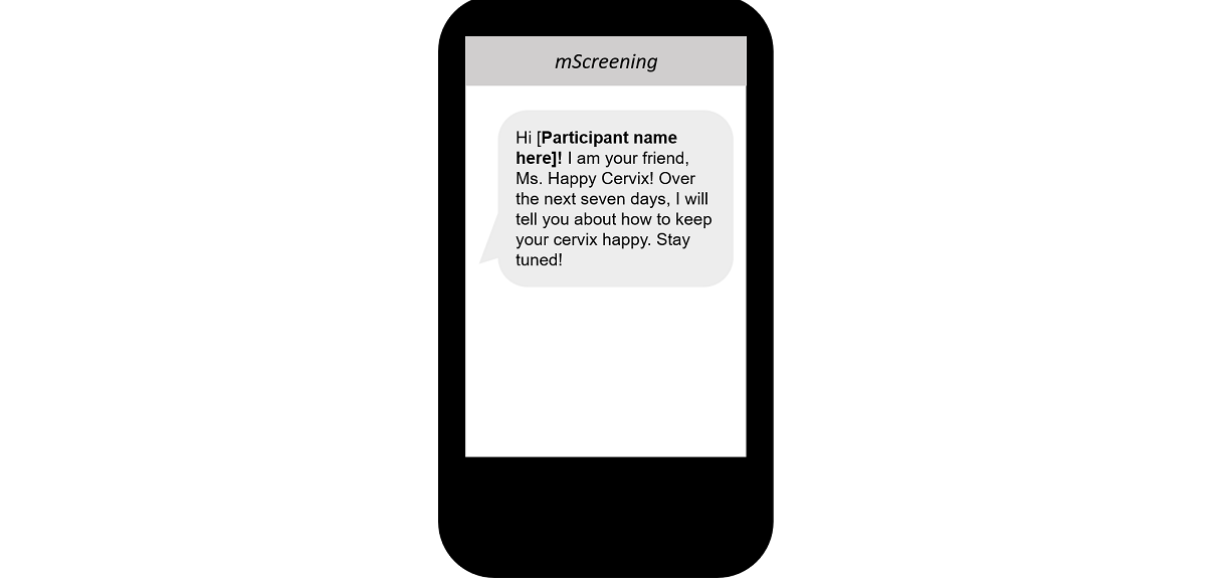
Figure 9. Mobile screening message example: tailored welcoming message that addressed the participant by her first name or nickname.